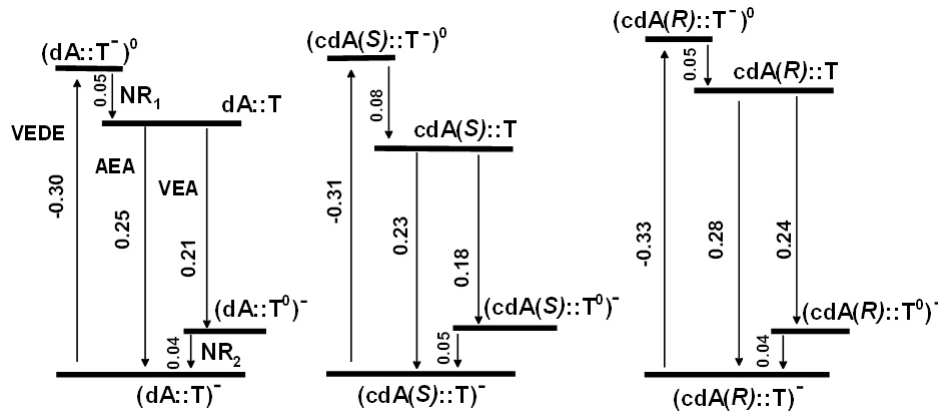
Figure 2. Scheme of energy changes, in eV, during the electron attachment to cdA(S)::T , cdA(R)::T and dA::T nucleoside pairs. Table 1. The electronic properties, in eV, of cdA(S)::T , cdA(R)::T and dA::T nucleoside pairs calculated on B3LYP 6-31++G**// B3LYP 6-31++G** level of theory.